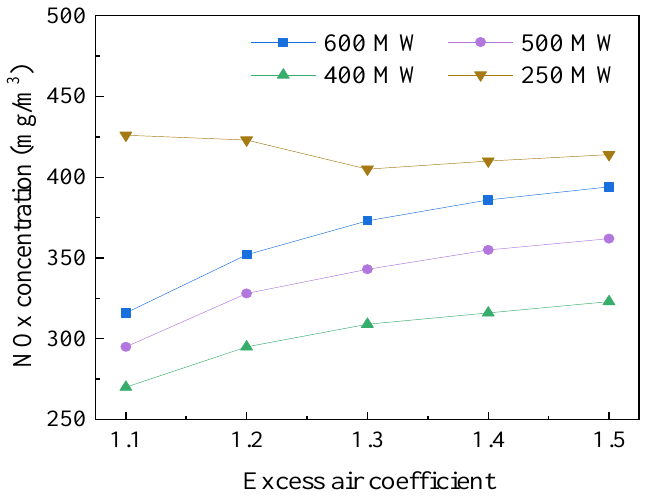
Figure 10. Variation in NOx concentration with excess air coefficient at the economizer outlet.